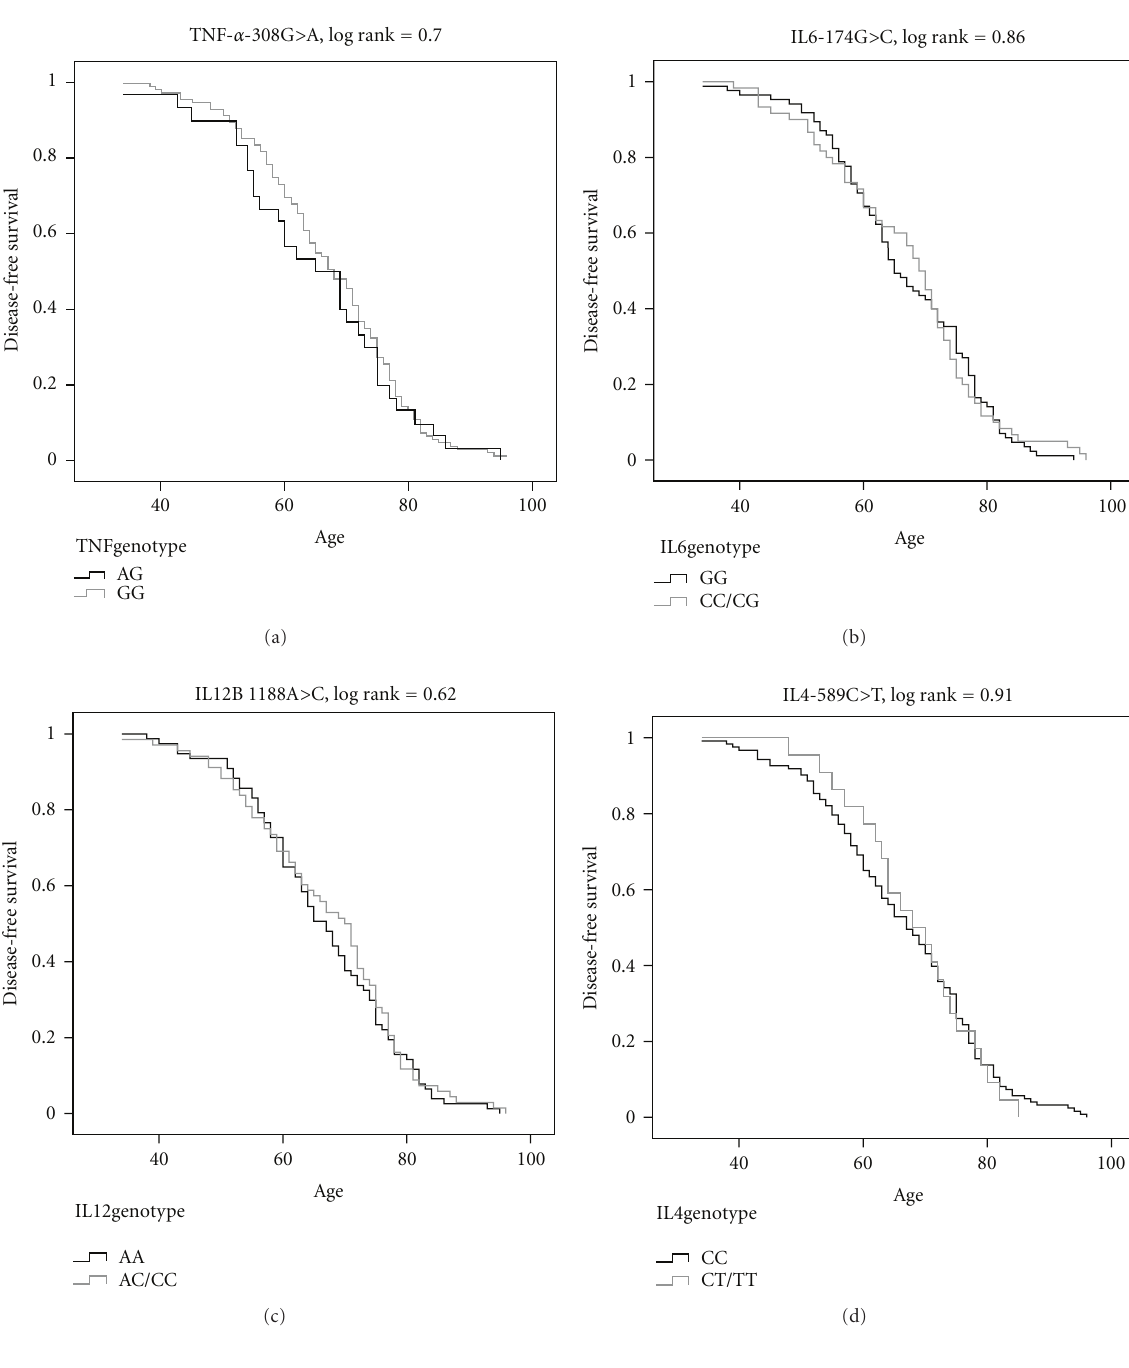
study investigated the possible genetic contribution of functional polymorphisms of major inflammatory molecules (i.e., TNF- α -308G > A, IL6-174G > C, IL12B 1188A > C, IL4- 589C > T and IL10-1082G > A) in the age of onset and 6- month outcome of an acute IS. Genotyping was based on a PCR-allele discrimantion technique without oligonucleotide probes [29], which yielded comparable allele frequencies to those previously reported using di ff erent methods